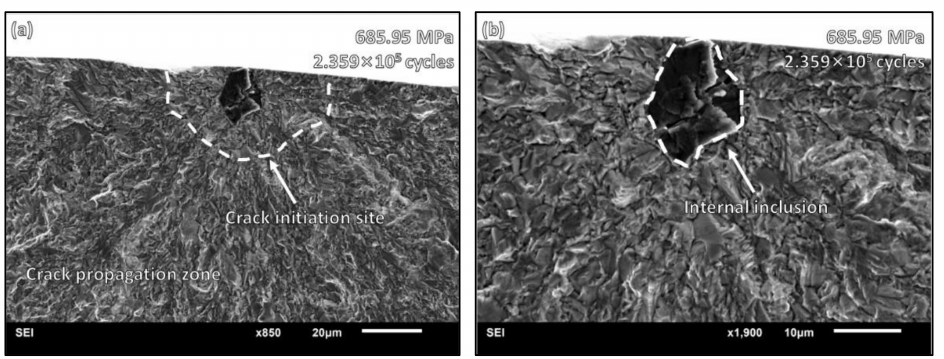
Figure 5. HCF fracture morphology: ( a ) crack initiation site on surface; ( b ) surface inclusion where initial cracks begin propagation.